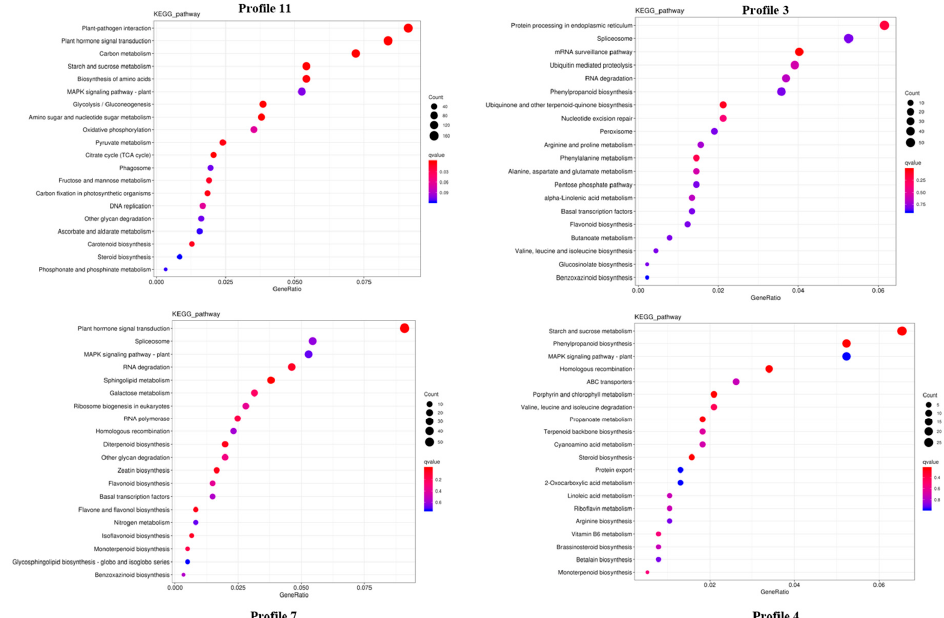
Figure 5. KEGG analysis of significant clusters ( p < 0.05) in P. cyrtonema.